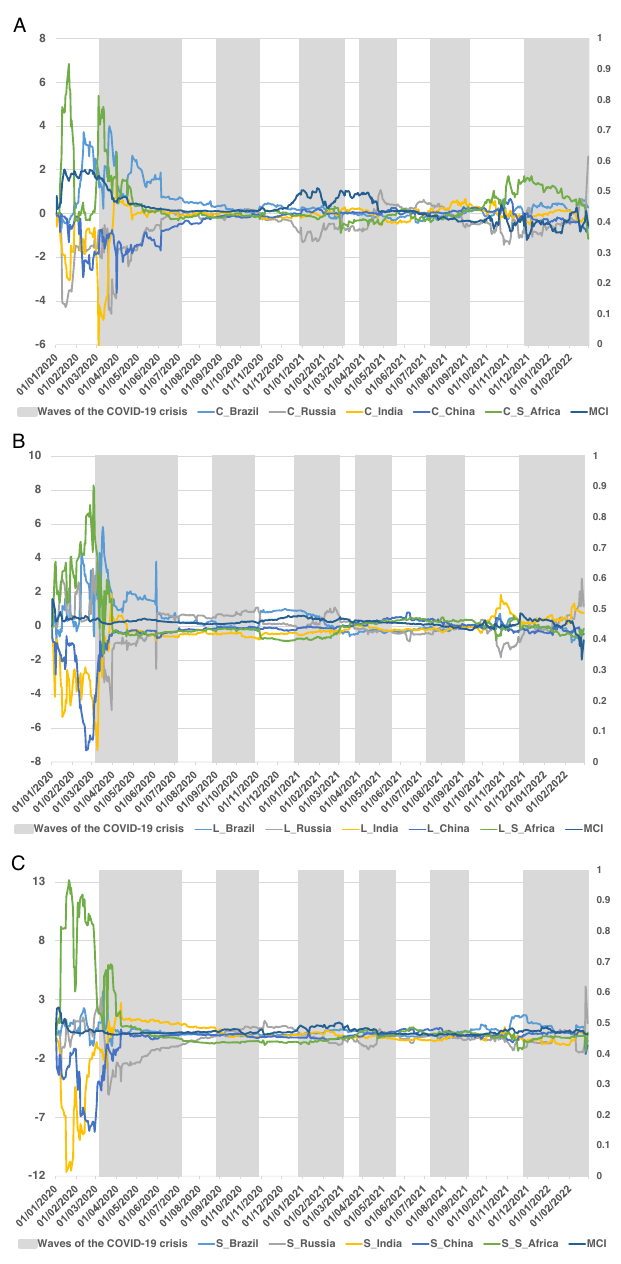
Fig. 4 Net dynamic total connectedness of the three components of BRICS term structure. Figure plots the net time-varying connectedness measure between the BRICS term structure of interest rates (decomposing into level ( A ), slope ( B ), and curvature ( C )) using the TVP-VAR framework (Antonakakis and Gabauer, 2017), during the waves of the COVID-19 pandemic